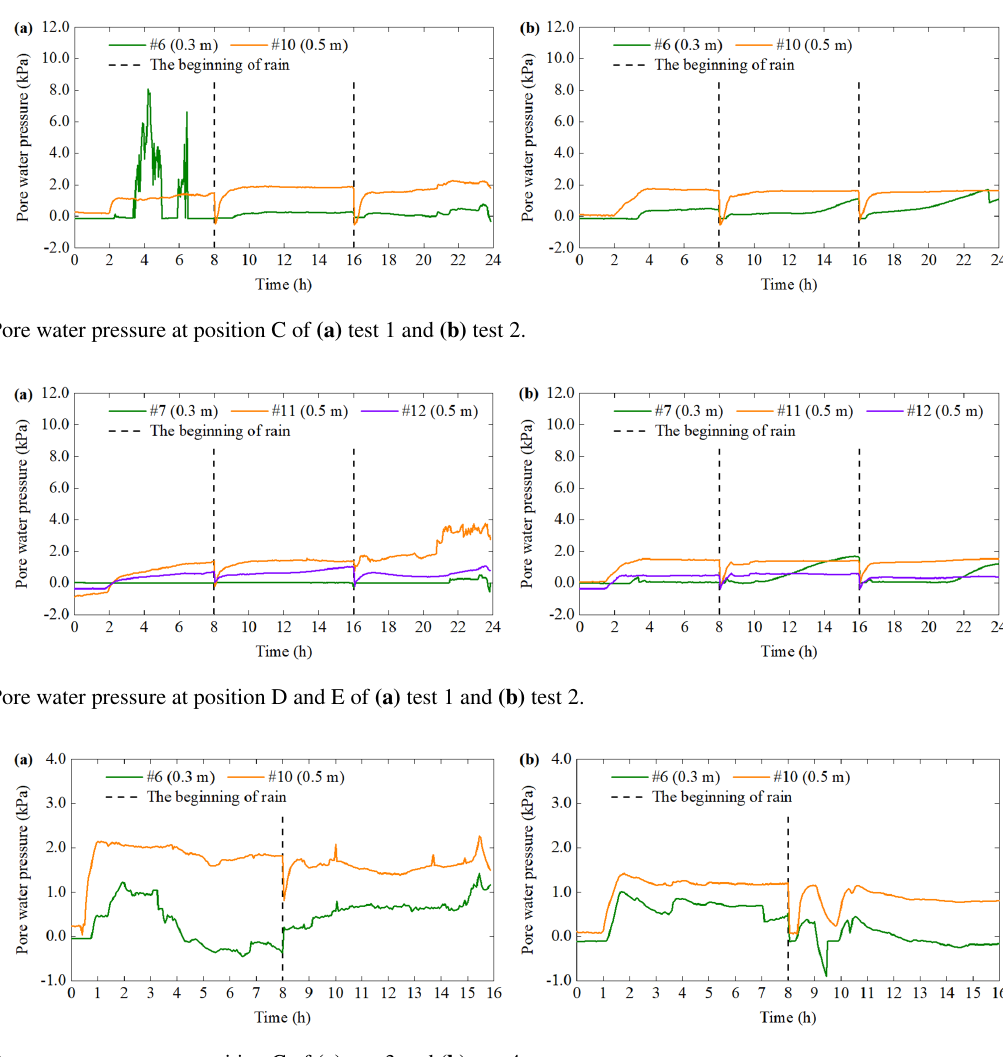
Figure 15. Pore water pressure at position C of (a) test 3 and (b) test 4.